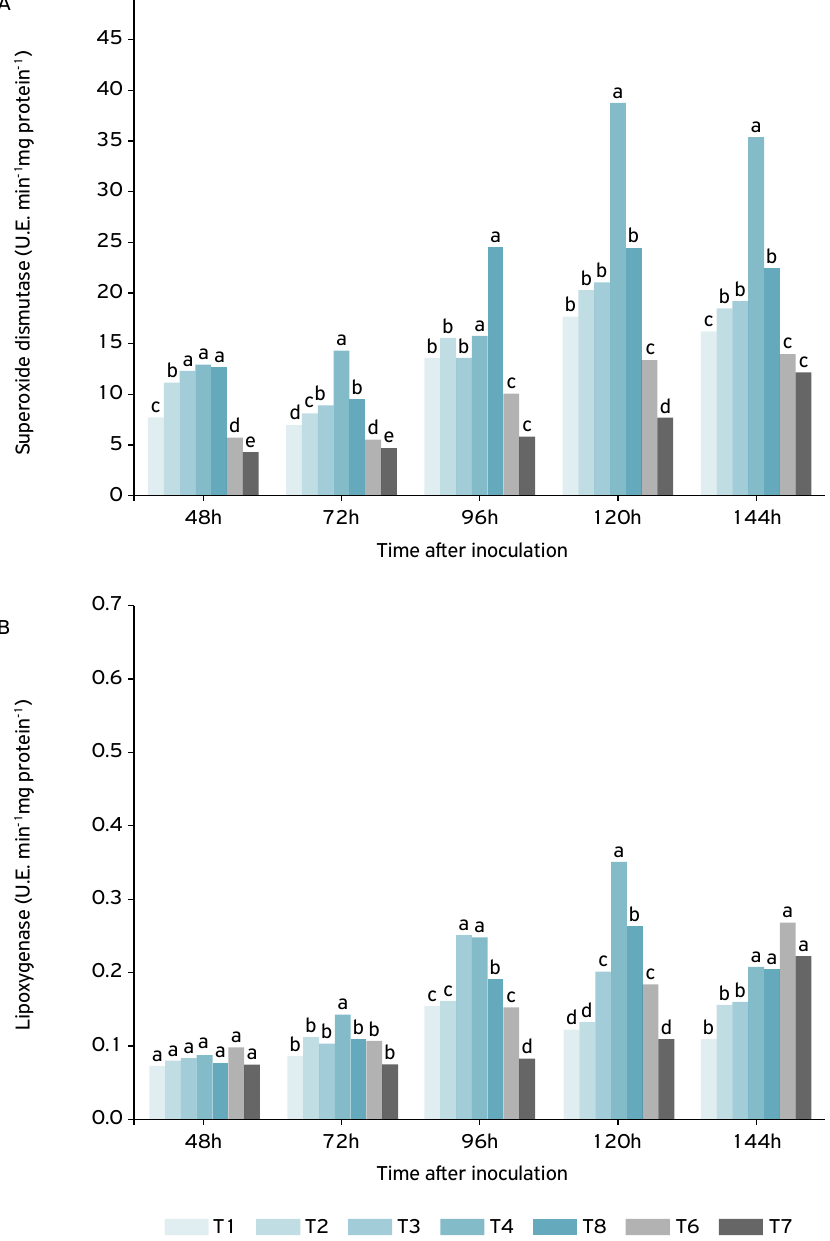
Averages followed by distinct letters between treatments differ by the Scott-Knott test at the 5% probability level; T1: suspension of Aspergillus japonicas ; T2: suspension of Trichoderma tomentosum ; T3: salicylic acid; T4: acibenzolar-s-methyl; T5: fungicide (Azoxystrobin with Tebuconazole); T6: application of sterile distilled water with inoculum of Bipolaris sorokiniana ; T7: without any Figure 3. Activity of the enzymes (A) superoxide dismutase and (B) lipoxygenase after inoculation of the Bipolaris sorokiniana pathogen.